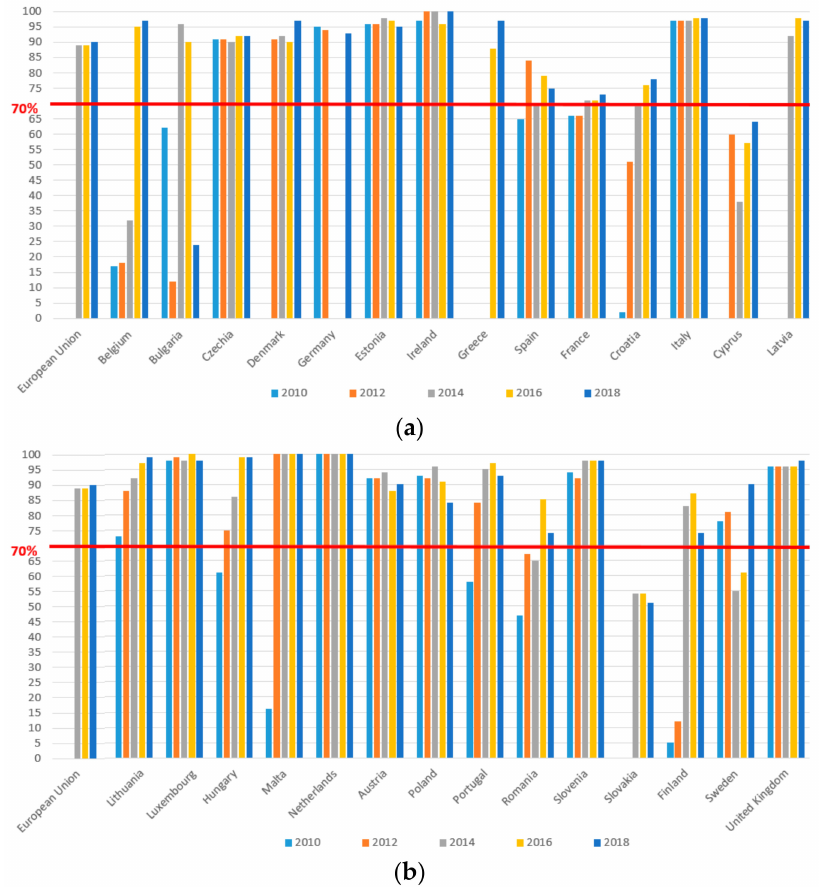
Figure 1. Recovery rate of construction and demolition waste in EU member states in the period 2010–2018, ( a ) EU, Belgium—-Latvia, ( b ) EU, Lithuania—-United Kingdom [13] (Eurostat,